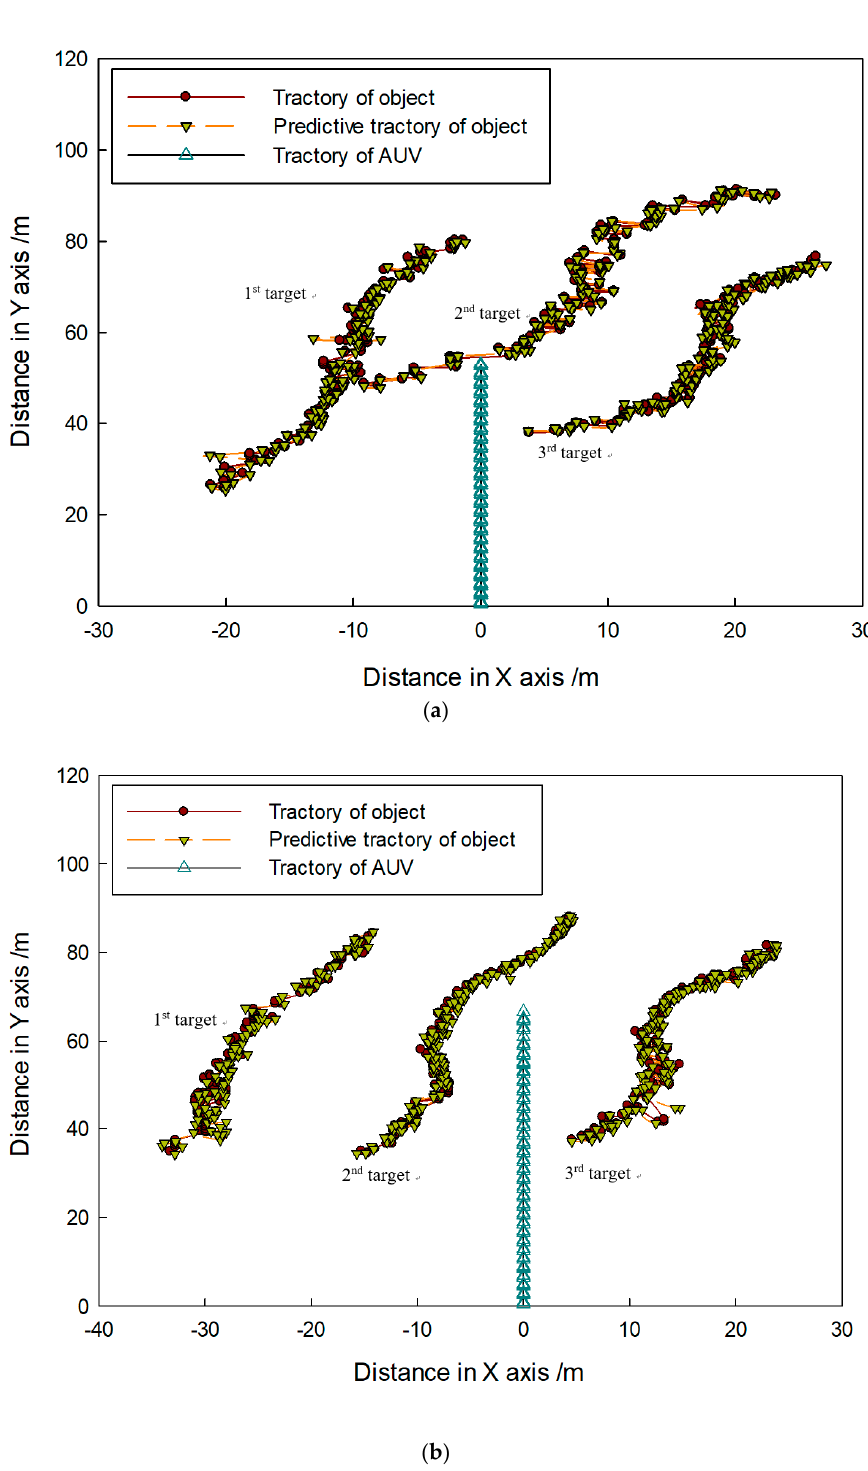
Figure 23. Target-tracking trajectory in ( a ) first and ( b ) second sequence of FLS images.